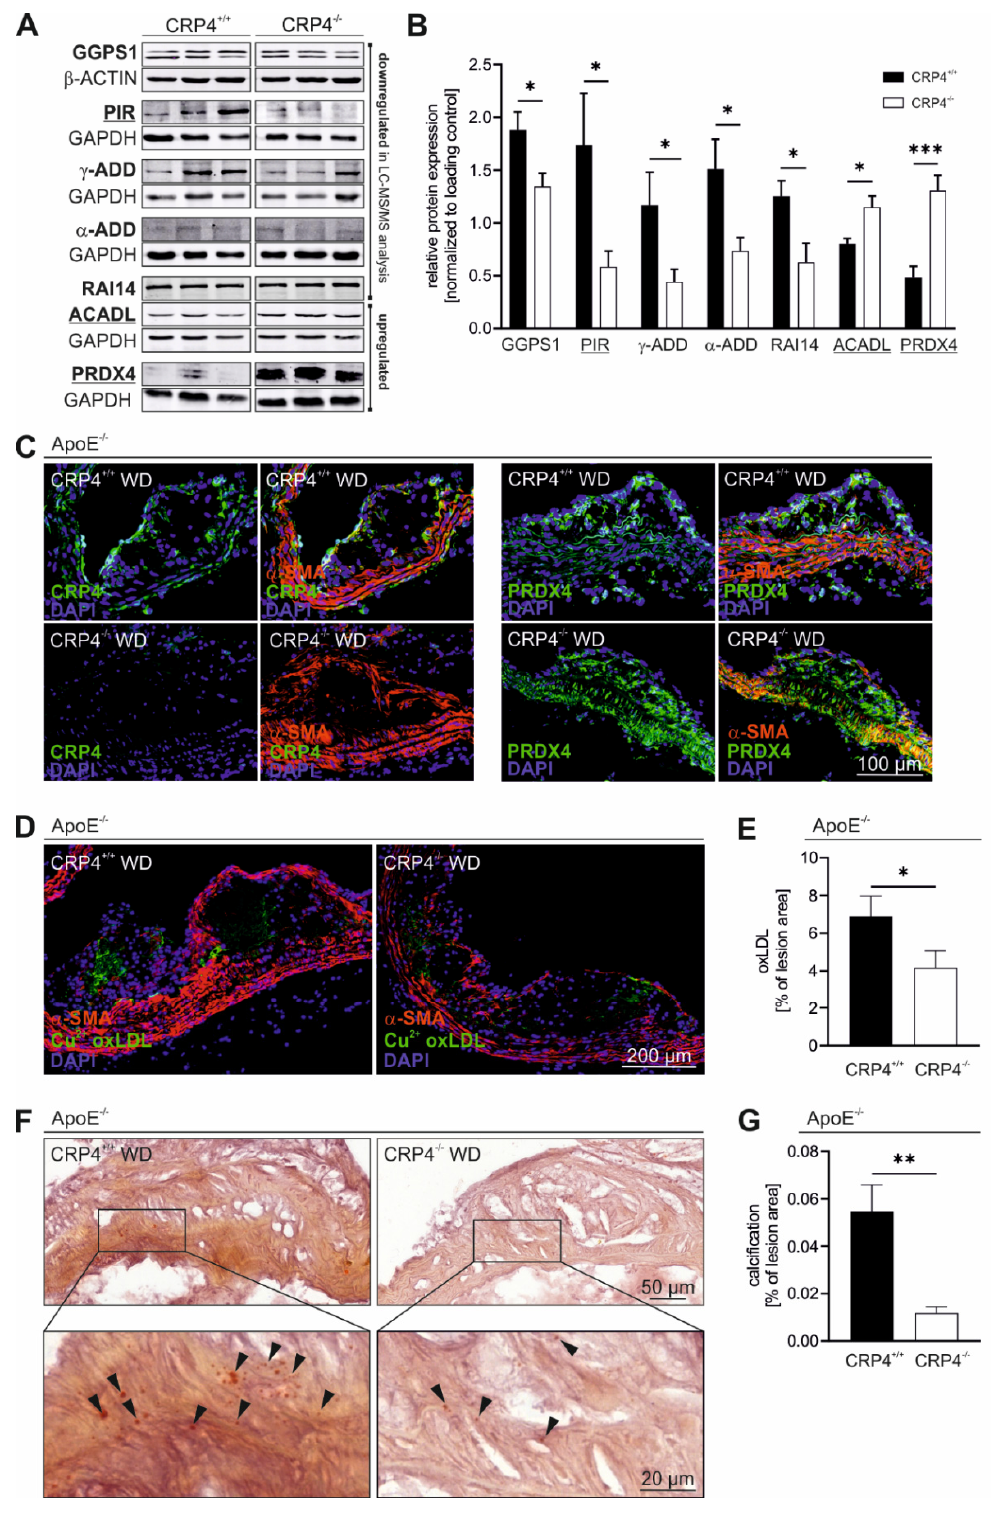
Figure 5. Vascular CRP4 regulates the expression of several proteins playing key roles in “oxidation reduction” and in atherosclerotic plaque formation . ( A , B ) Significantly regulated proteins identified in LC-MS/MS proteomic analysis (Table 1) of CRP4 WT and KO synthetic VSMCs were validated applying immunoblot technique. GetGo analysis indicated an enrichment of proteins involved in “oxidation reduction” (GO: 0055114) (underlined). Geranylgeranyl diphosphate synthase 1 (GGPS1), retinoic acid induced protein (RAI) 14, alpha- and gamma-Adducin ( α - and γ -ADD) and Pirin (PIR)